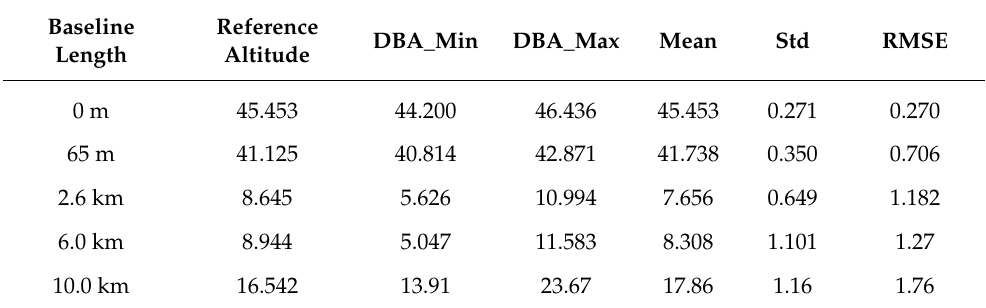
Table 1. The DBA altitude statistical results of the five different baseline lengths (Unit: m).